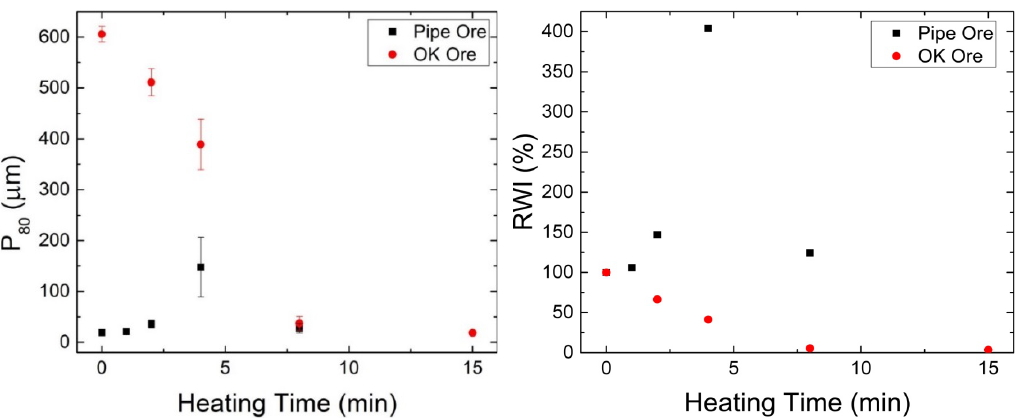
Figure 8. Product size (P 80 ) ( Left ) and RWI ( Right ) versus microwave heating time for Pipe and OK ores after grinding [48].